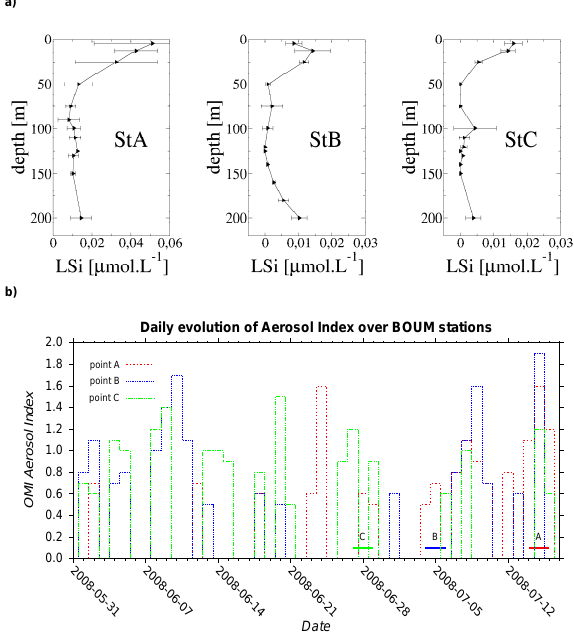
Figure 10. Fig. 10. (a) Mean vertical profiles of lithogenic silica, LSi, per- formed at each Long duration station. Horizontal bars represent the standard deviation. (b) Temporal evolution of the OMI daily prod- ucts of absorbing aerosol